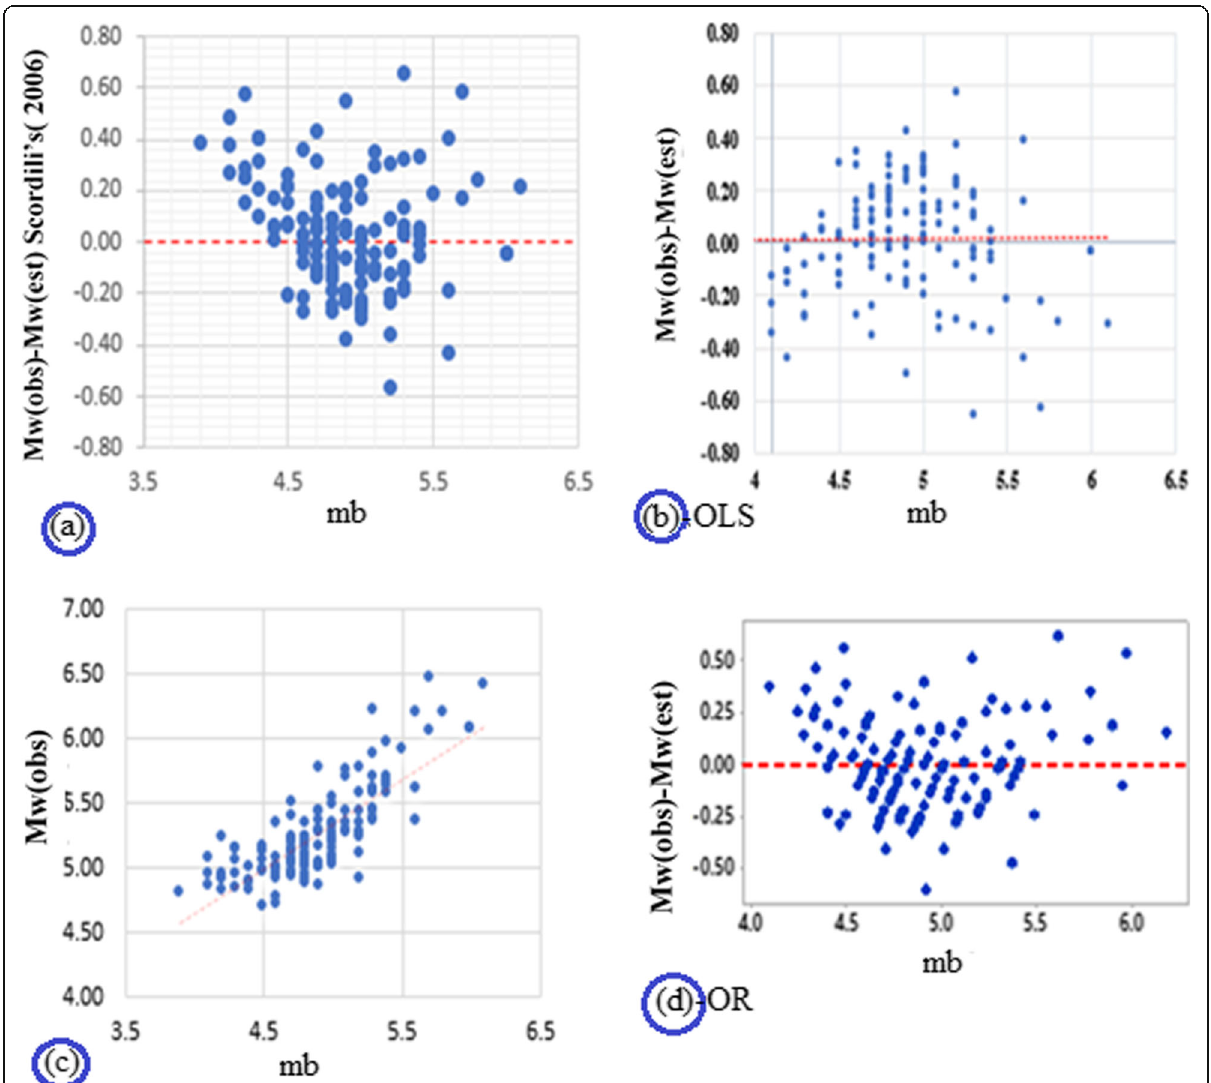
Fig. 4 ( a ) Residual graphs of Scordilis (2006) regression for Mw (obs)-Mw (est) vs mb ( b ) Mw (obs)-Mw (est) to mb [OR] ( c ) Mw (obs) to mb ( d ) Residual graphs of this study for Mw (obs)-Mw (est) vs mb